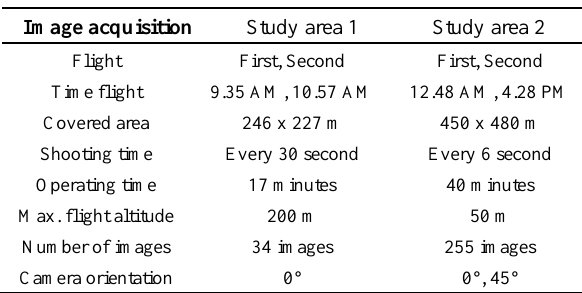
Figure 1. Study areas (a) Agriculture field in Panyu Qu, Guangzhou (b) Yangzte Normal University, Fuling, Chongqing